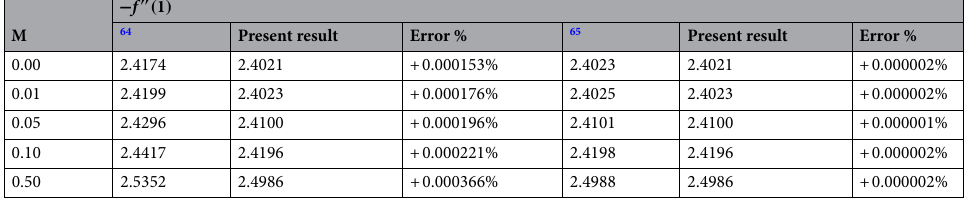
Table 5. Comparison and error analysis of current work with published works Ishak et al. 64 and Gholinia et al. 65 when S = 0, t = 0, K s = 0, F r = 0 . It is observed from the error analysis (Ishak et al. 64 and present work) for growing values of magnetic parameter M the error is increased, while it is constant for the second case (Gholinia et al. 65 and present work). It is noticed for the seconds case that the result is approximately equal, and less error is observed